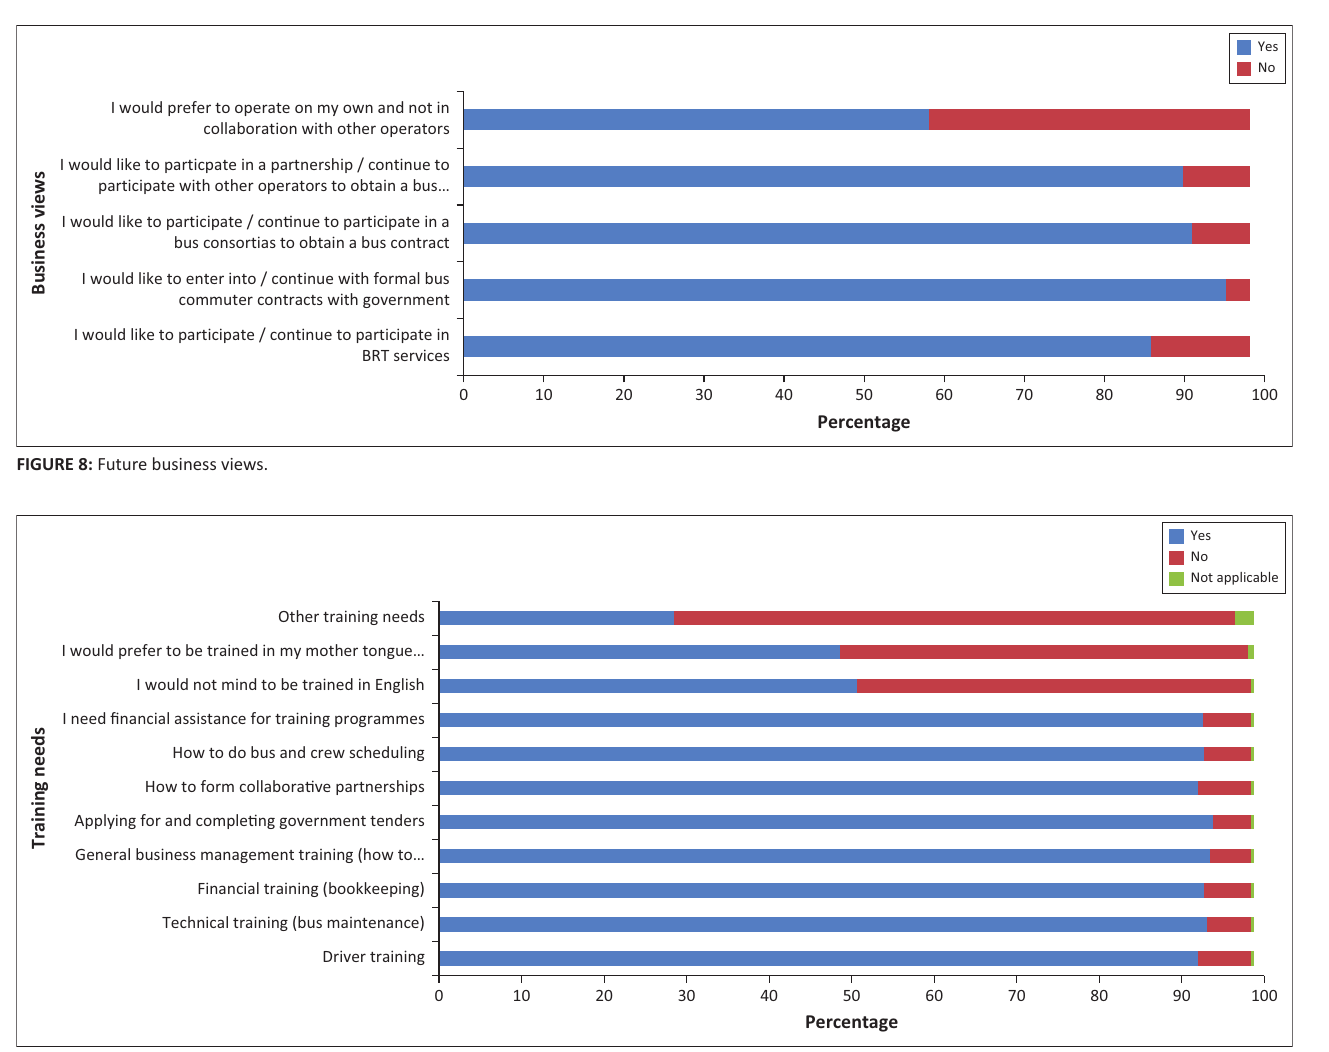
FIGURE 9: Training needs.